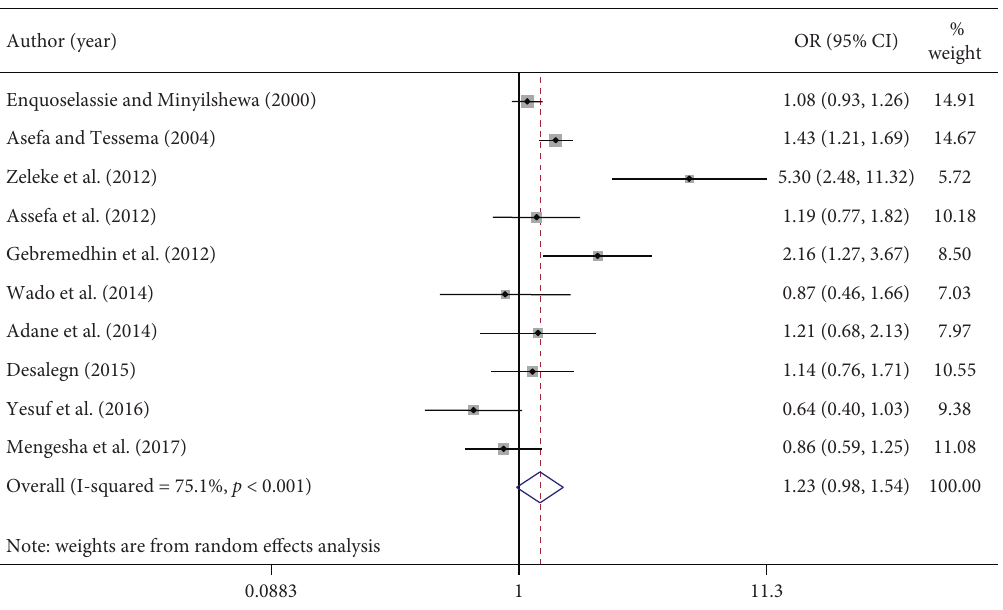
Figure 7: Forest plot displaying the association of being primipara and low birth weight in